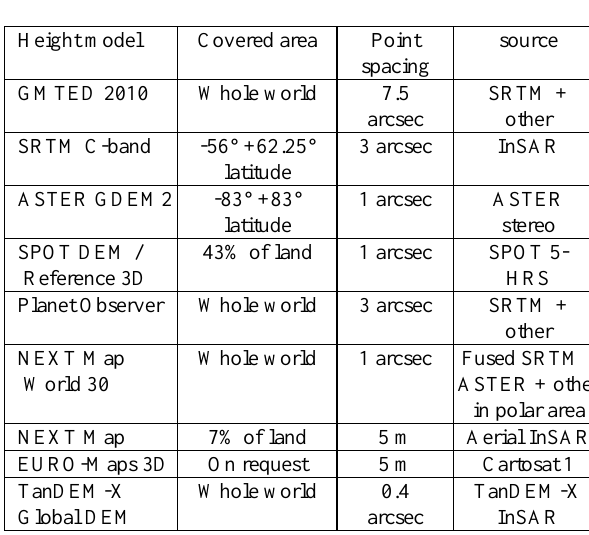
Table 2: large area covering height